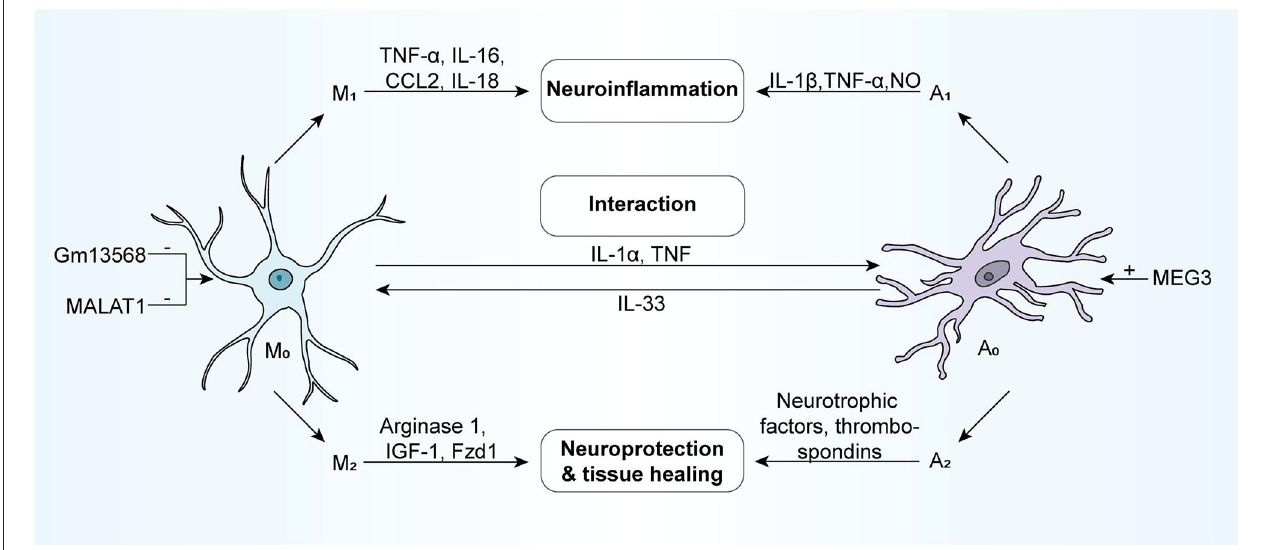
FIGURE 1 | NcRNAs can involve in the regulatory processes of the activation of microglia and astrocyte. Generally, microglia and astrocytes respond to external stimuli as a whole, functionally restricting each other and coordinating with one another. According to activation status, they are usually divided into two phenotypes: the neurotoxic phenotype (M1/A1) and the neuroprotective phenotype (M2/A2). The neurotoxic microglia, which secretes pro-inflammatory cytokines (e.g., TNF- α , IL-16, and so forth) and chemokines (e.g., CCL2, IL-18, and so forth), participate in neuroinflammation. While the neuroprotective microglia could release Arginase 1, IGF-1, Fzd1, and so forth, contributing to neuroprotection and tissue healing. The neurotoxic astrocytes induce the production of pro-inflammatory factors such as IL-1 β , TNF- α , NO, and so forth, while neuroprotective astrocytes secrete neurotrophic factors and thrombospondins in large quantities. Astrocytes and microglia can directly interact with one another via molecules like IL1a, TNF, and IL-33. M1, neurotoxic microglia; A1, neurotoxic astrocyte; M2, neuroprotective microglia; A2, neuroprotective astrocyte; IGF-1, insulin-like growth factor 1; Fzd1,